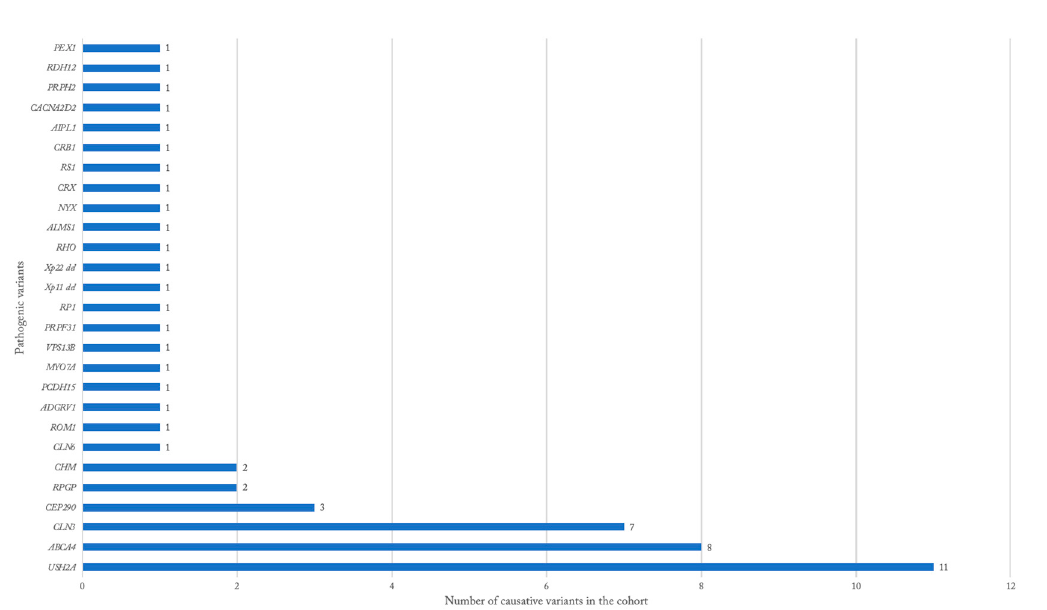
Figure 2. Distribution of the pathogenic genetic results . Table 1 . Pathogenic genetic variants per retinopathy identified in our cohort .